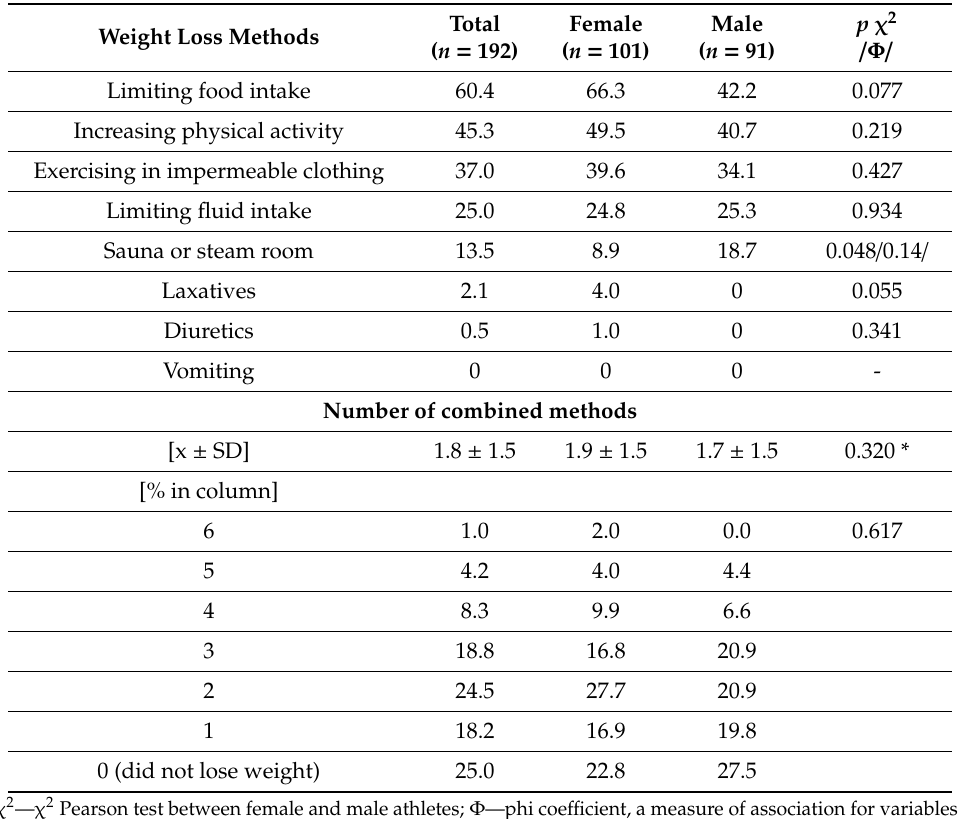
Table 1. The use of weight loss methods in study sample